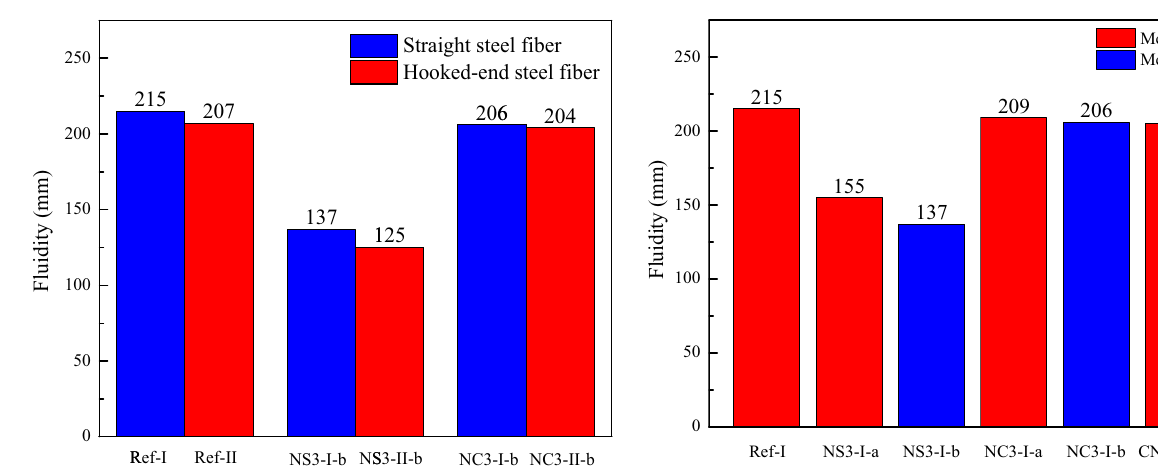
Figure 6: E ff ect of steel fi bre type on UHPC paste fl uidity.